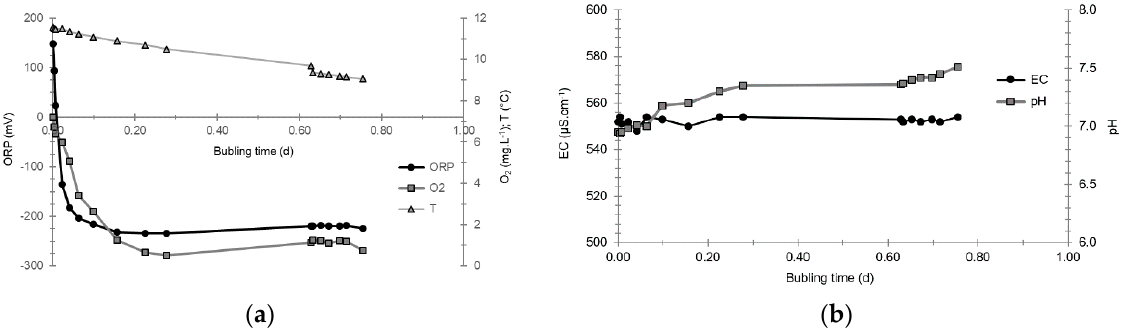
Figure 7. Evolution of the physicochemical parameters of the water in the tank during hydrogen bubbling: ( a ) oxidation- reduction potential (ORP), temperature (T), and dissolved O 2 ; and ( b ) electrical conductivity (EC) and pH.